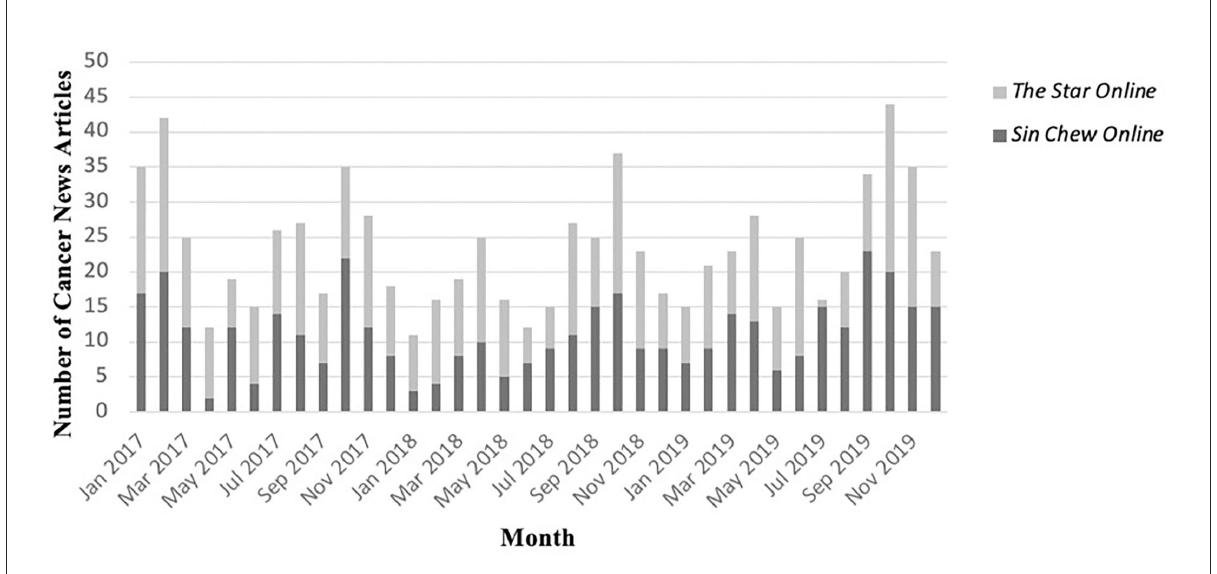
FIGURE1 Number of cancer news articles reported by The Star Online and Sin Chew Online ( N =